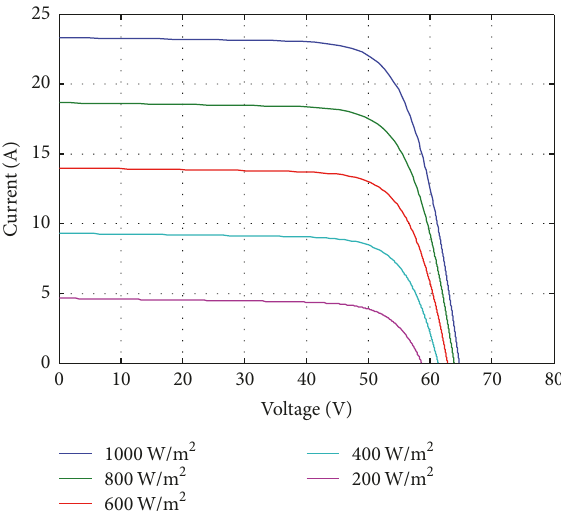
Figure 6: 𝐼 - 𝑉 curves for PV